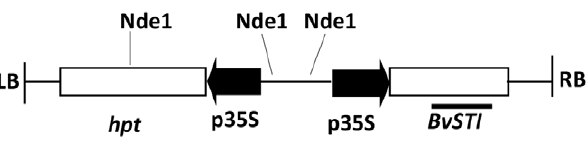
Figure 1. Schematic of the reconstructed BvSTI gene in the pCAMBIA1301 transformation vector (pBvSTI). RB, right border; LB, left border; p35S, cauliflower mosaic virus (CaMV) 35S promoter; hpt , hygromycin phosphotransferase selectable marker gene; NdeI restric- tion enzyme sites; arrows indicate direction of transcription from the p35S promoter. Horizontal bar indicates the 400-bp fragment of the BvSTI gene used as a probe for Southern